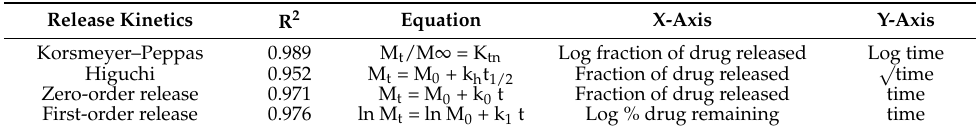
Table 3. Invitro drug release kinetics with correlation